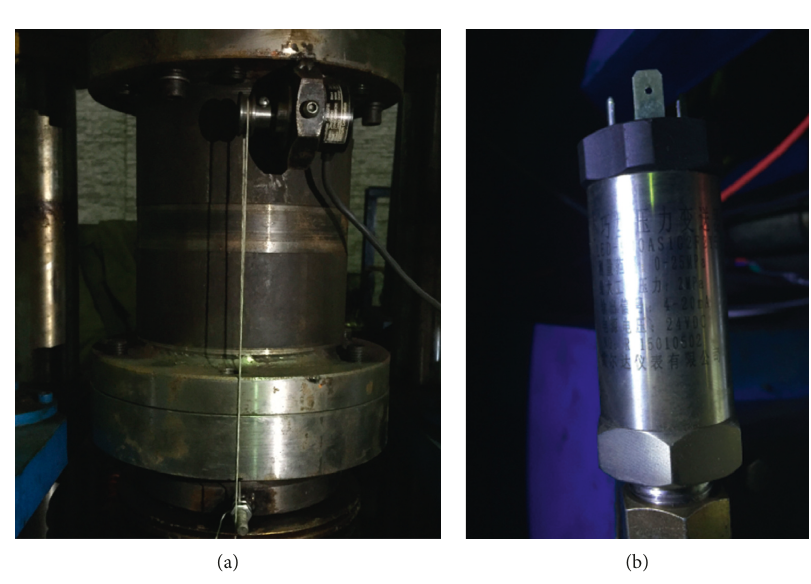
Figure 5: (a) Displacement sensor and (b) pressure sensor.